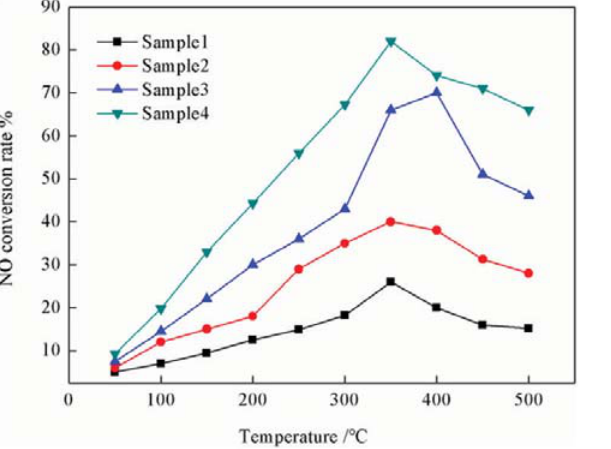
Figure 9: Comparison the denitrification rate for progressive treatment process.